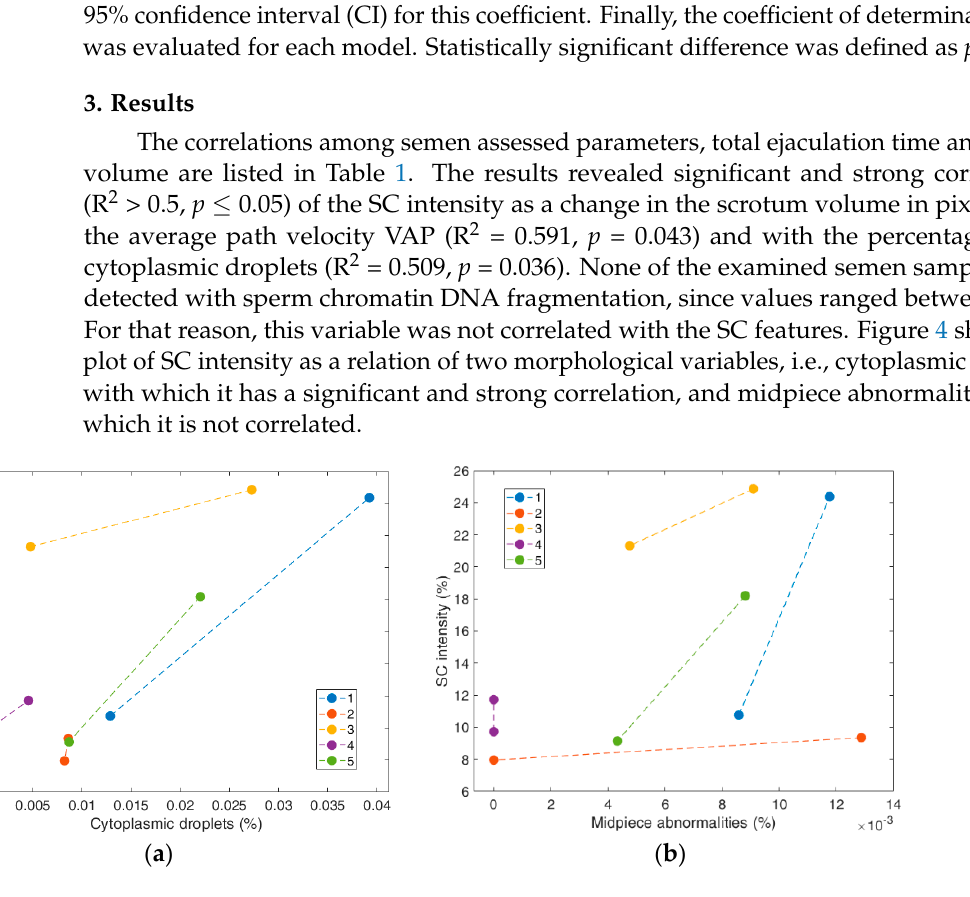
Figure 4. Plot of SC intensity (%) in relation to ( a ) cytoplasmic droplets (%), and ( b ) midpiece abnormalities (%), grouped by boar. SC intensity shows a significant and strong correlation with cytoplasmic droplets, but not with midpiece abnormalities. Each dot with a different color indicates a different boar.